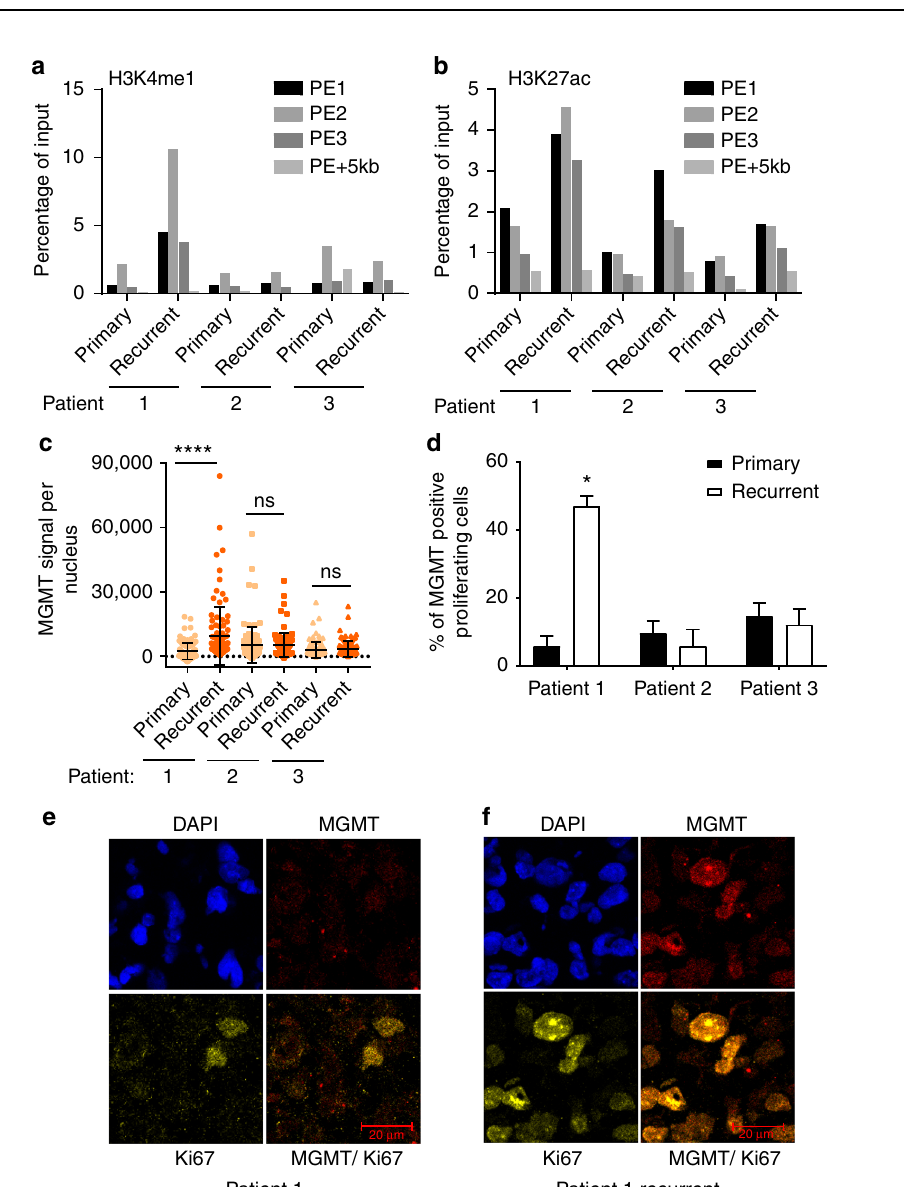
Fig. 3 Enhancer activity and MGMT expression in three pairs of GBM patient samples. a , b Relative occupancy of H3K4me1 ( a ) and H3K27ac ( b ) in the K- M enhancer region in primary and matched recurrent tumors from three GBM patients was analyzed by ChIP-qPCR using primers described in Fig. 2. c MGMT expression level in each tumor was analyzed by immuno fl uorescence. The MGMT signal (area × average intensity) from 100 individual nuclei was